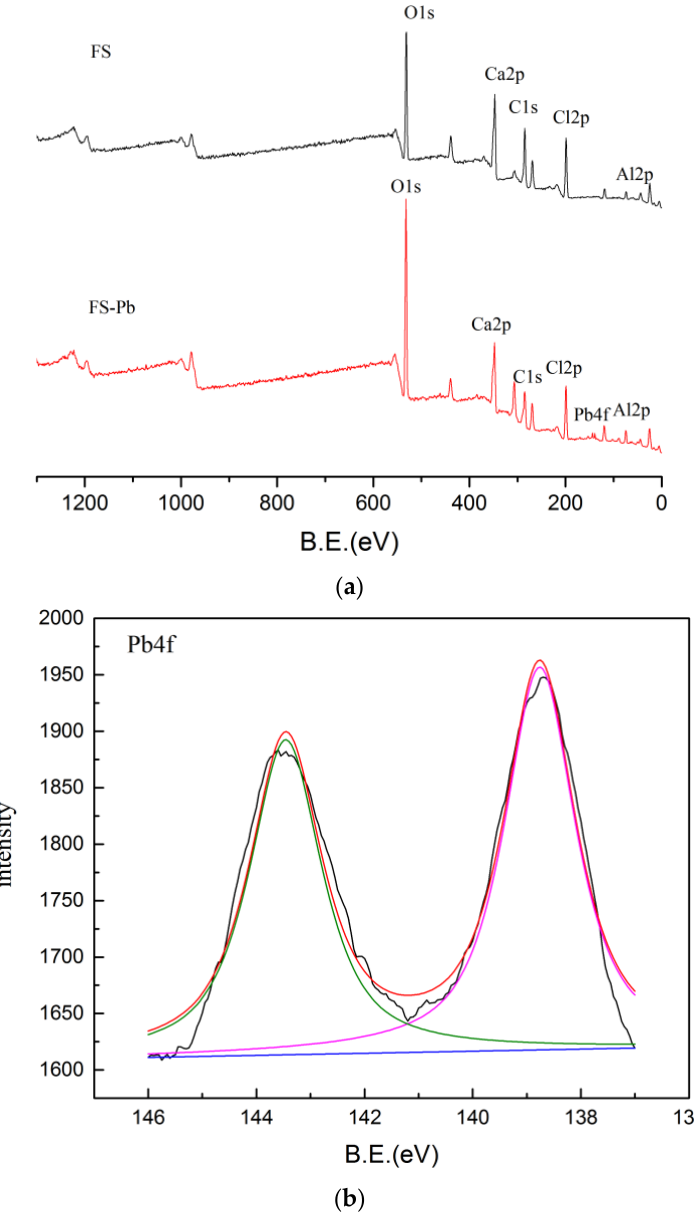
Figure 10. XPS analysis of calcium chloroaluminate solidified Pb. ( a ) XPS full spectrum before and after calcium chloroaluminate curing Pb. ( b ) Partial magnification of binding energy of Pb. Table 7. XPS binding energy of main elements before and after calcium chloroaluminate curing. Spectrum Lines